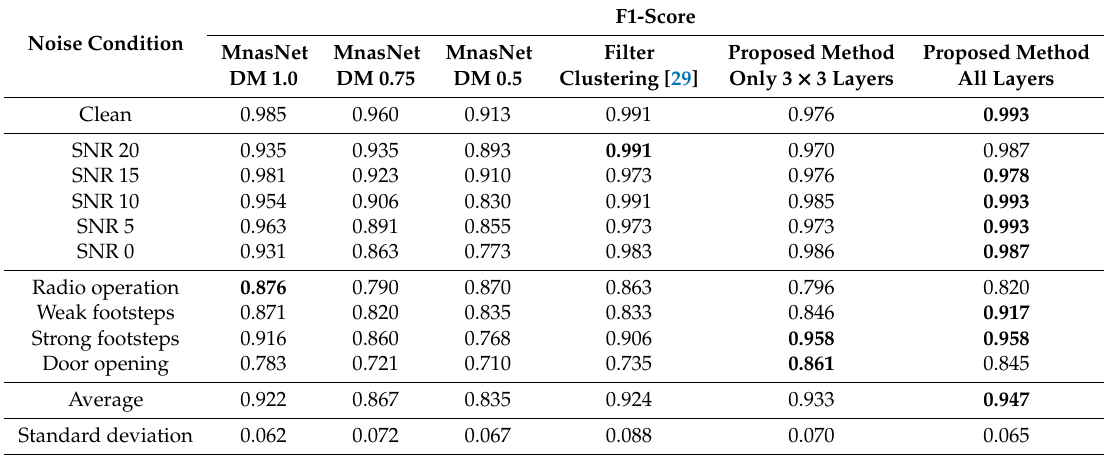
Table 4. Sound-based pig abnormality identification results (Train: clean + SNR 0 synthesized dataset).